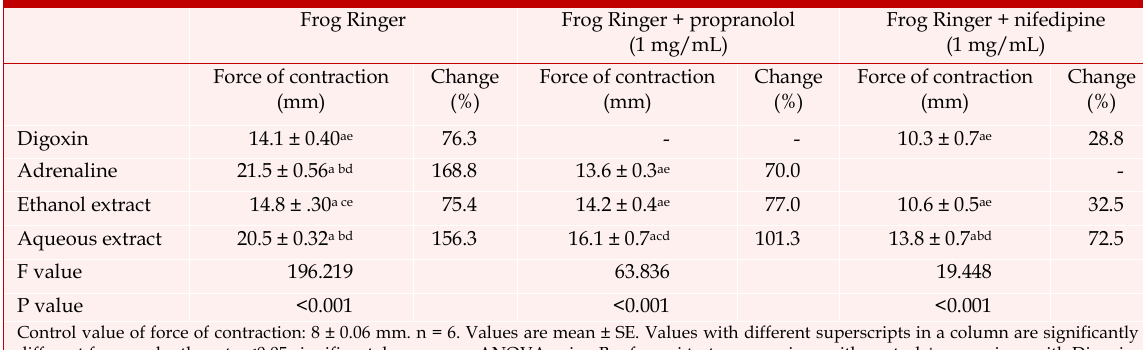
Effect of Premna serratifolia extract on force of contraction using isolated frog heart perfusion